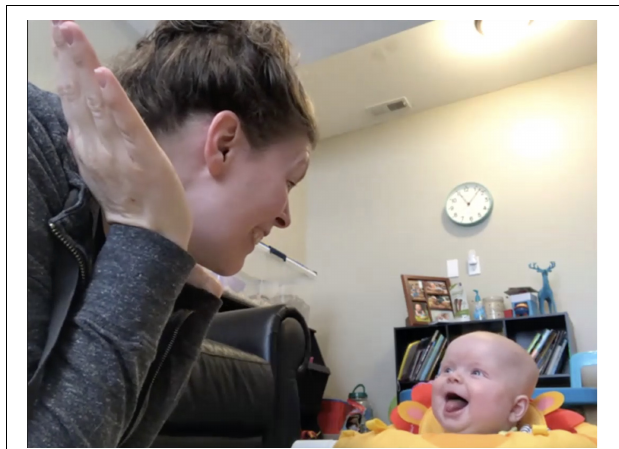
joined the session to record the visit. Since the recorder did not share their screen, the recorder was able to make the participants’ face as large as possible ( Figure 5 ). Because remote data collection is currently underutilized as an observational data tool, sharing